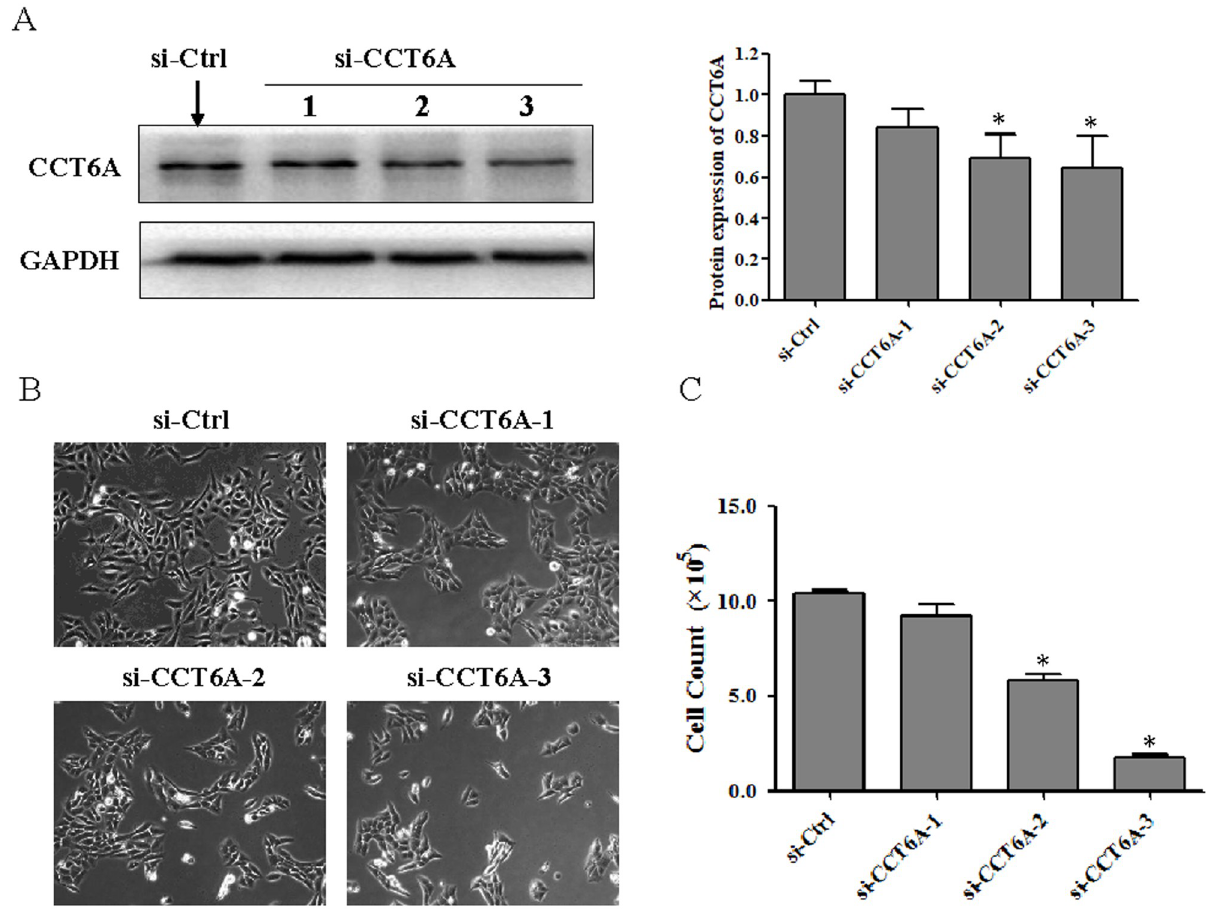
Fig 2. The effect of CCT6A knockdown on U-2 osteosarcoma cell growth. U-2 osteosarcoma cells were transfected with three different si-CCT6As or si-Ctrls for 72 h. (A) and Western blot analysis was performed to determine the protein expression of CCT6A. (B) The cells were counted with a Countstar Automated Cell Counter using the Trypan blue exclusion principle. (C) Morphological changes were observed by phase-contrast microscopy at × 100 magnification. The images shown represent three independent experiments. � p < 0.05 vs. si-Ctrl. CCT6A, chaperonin-containing TCP1 subunit 6A; siCT6A-3, CCT6A siRNA; si-Ctrl, control siRNA; siRNA, small interfering ribonucleic acid.